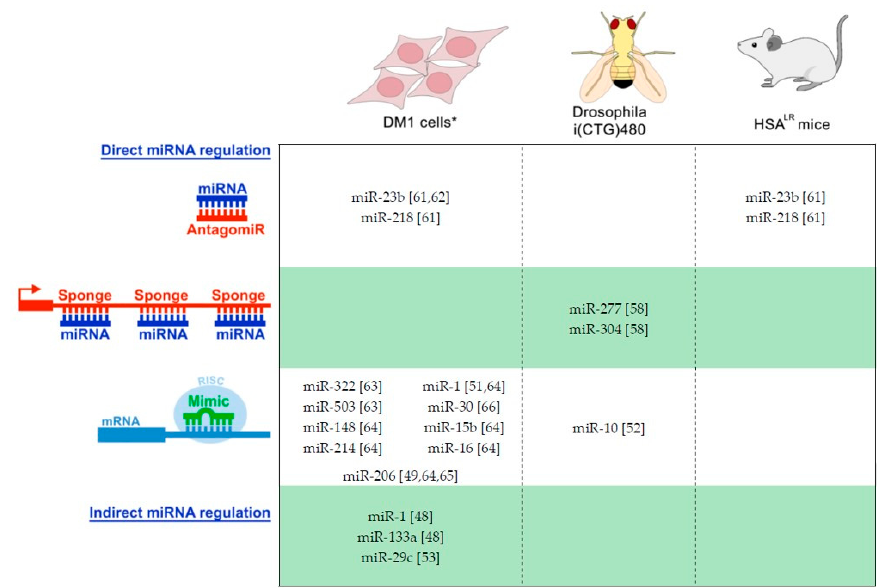
Figure 2. Therapeutic proof-of-concept approaches for DM based on the modulation of miRNA levels. Currently, three di ff erent model systems have been used for evaluation: cells* (human and murine lines), flies, and mice. In vivo miRNA interventions were performed in disease backgrounds to directly assess the therapeutic potential in DM. * Cell approaches used DM and non-disease lines indistinctly for therapeutic evaluation and for conceptual modulation of DM-related targets, respectively. As direct miRNA intervention technologies, antagomiRs, sponges, and miRNA mimic products, able to directly bind to miRNA targets, have been used [49,51,61–66]. But miRNA modulation has been achieved by indirect approaches such as the recovering of MEF2C levels in DM1 [48] or removal of the expanded CTG by CRISPR technology [53].